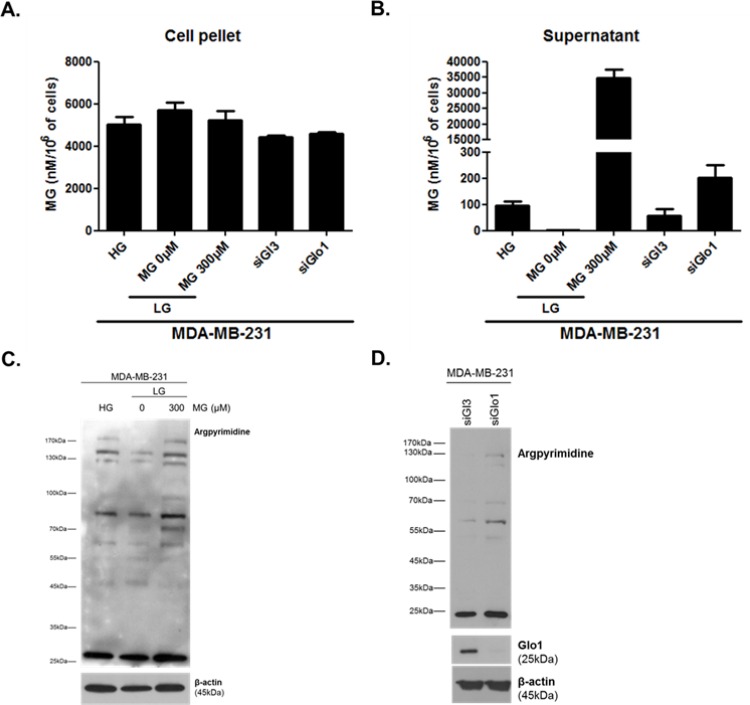
Intracellular (A) and extracellular (B) MG concentrations in MDA-MB-231 cells.MG adducts western blotting detection using anti-argpyrimidine antibody in MDA-MB-231 cells cultured in high and low glucose and upon exogenous MG treatment (C) and in Glo1-silenced cells (D).